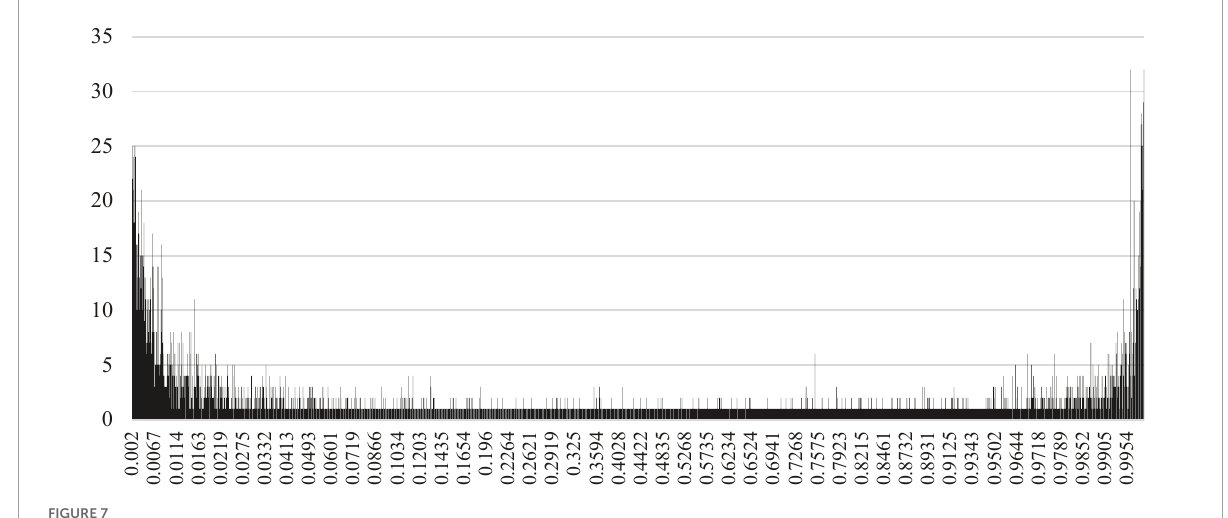
FIGURE7 Sentiment score of spam classification topics.